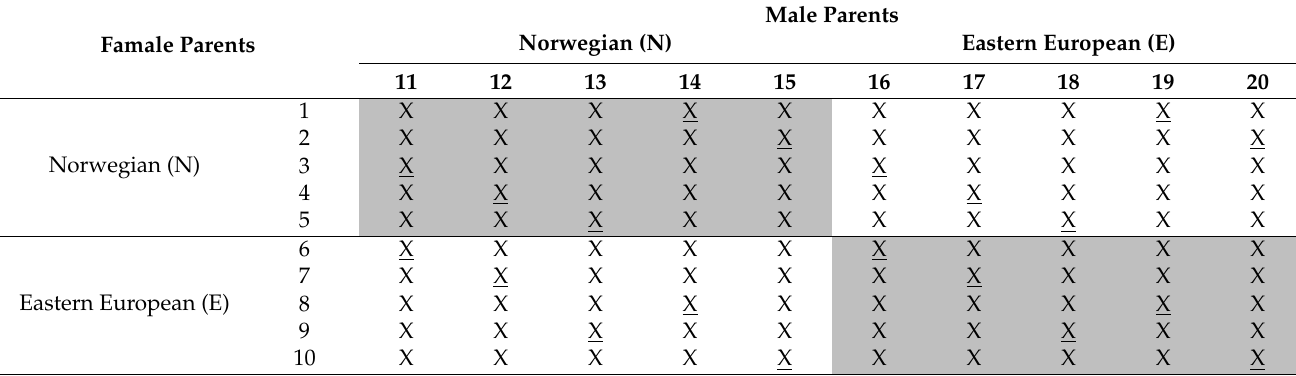
Table 2. The 100 factorial crosses made between 10 Norwegian (N) and 10 Eastern European (E) parents. The N × N and E × E families are indicted as shaded squares. The 20 families that were propagated by rooted cuttings are denoted by X. Male Parents Famale Parents